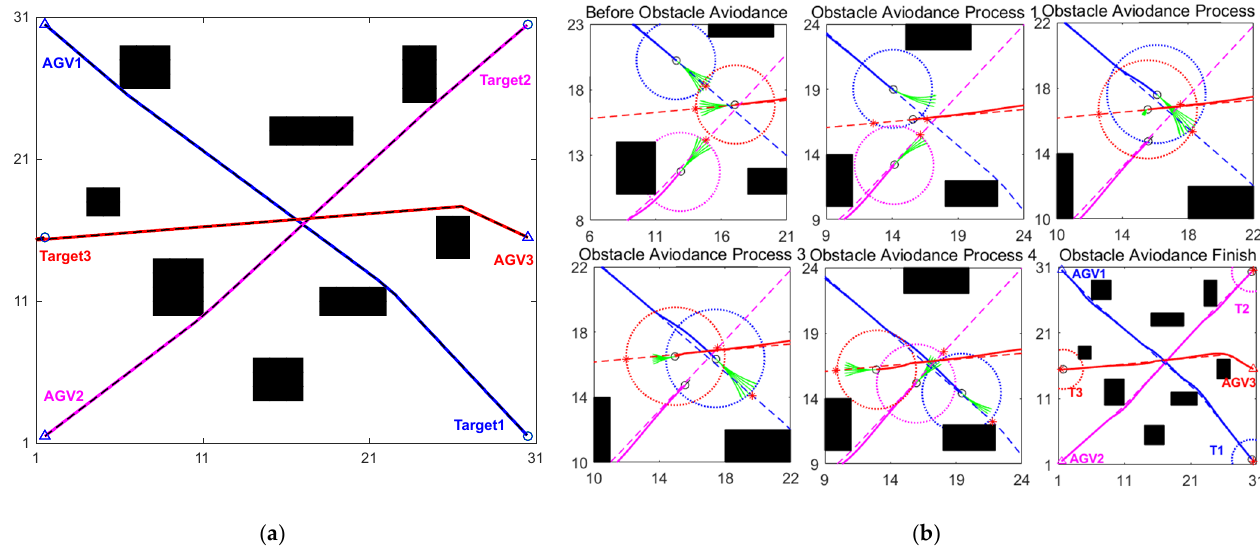
Figure 21. Multi-robot path planning 1. ( a ) Global path planning. ( b ) Robot local motion.